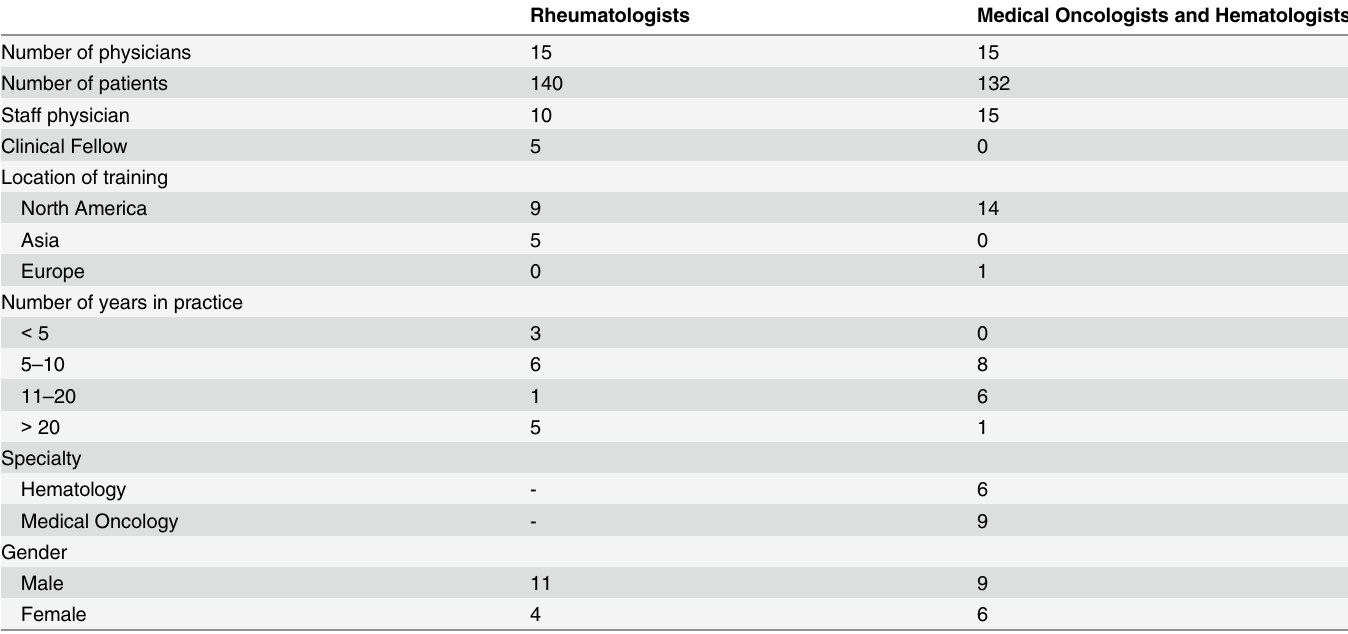
Table 1. Demographics of Physician Respondents.